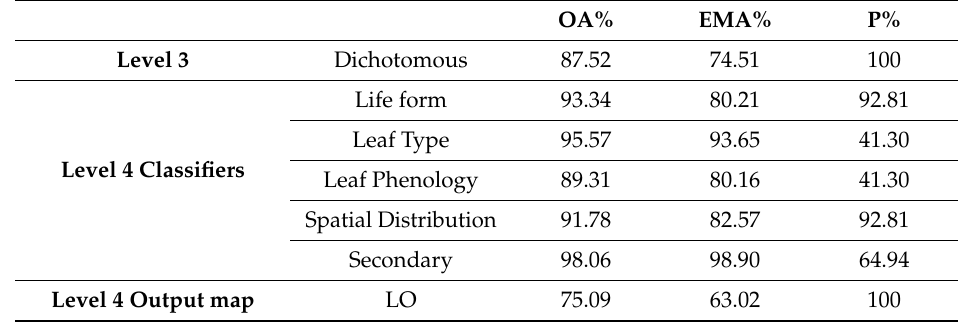
Table 10. Overall accuracy (OA) and EMA values for LO hierarchical classification. P is the percentage of the reference data used in each specific